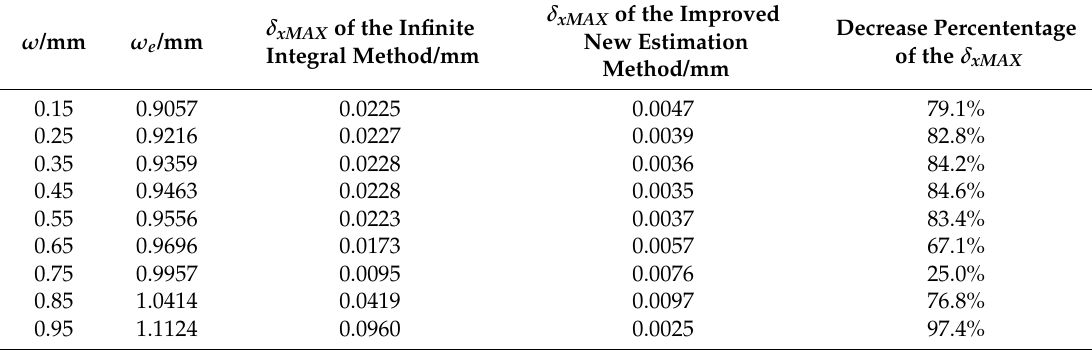
Table 1. Comparison of the δ xMAX between the improved new estimation method and the infinite integral method for different